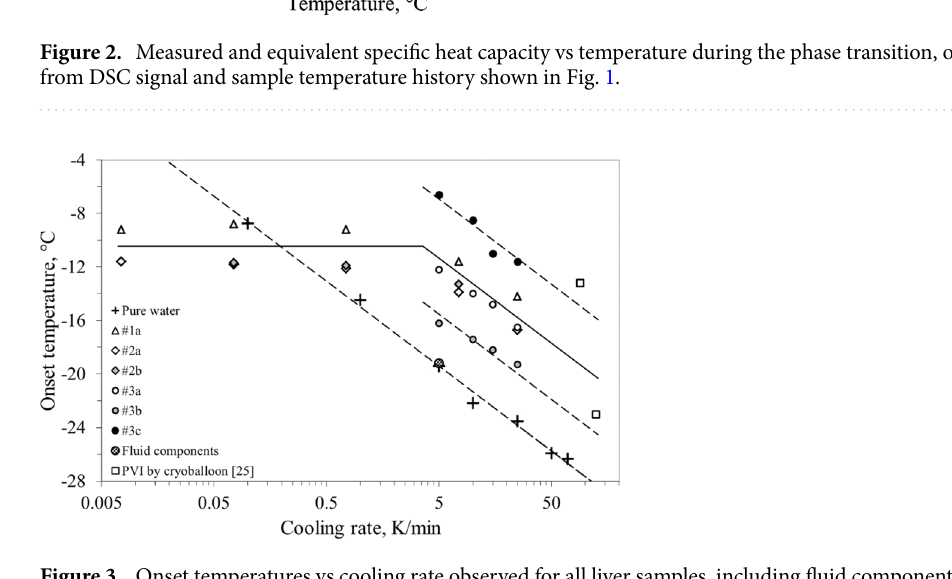
Figure 3. Onset temperatures vs cooling rate observed for all liver samples, including fluid components, pure water, and actual PVI by means of